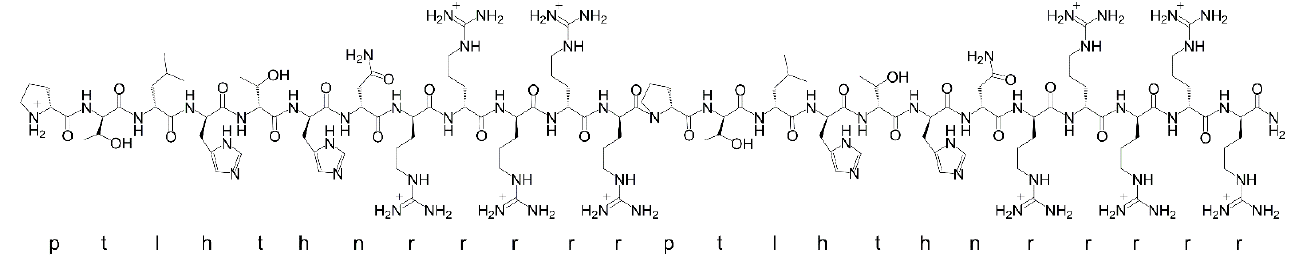
Figure 6. Lewis structure and single letter amino acid code of the d-enantiomeric peptide RD2RD2.